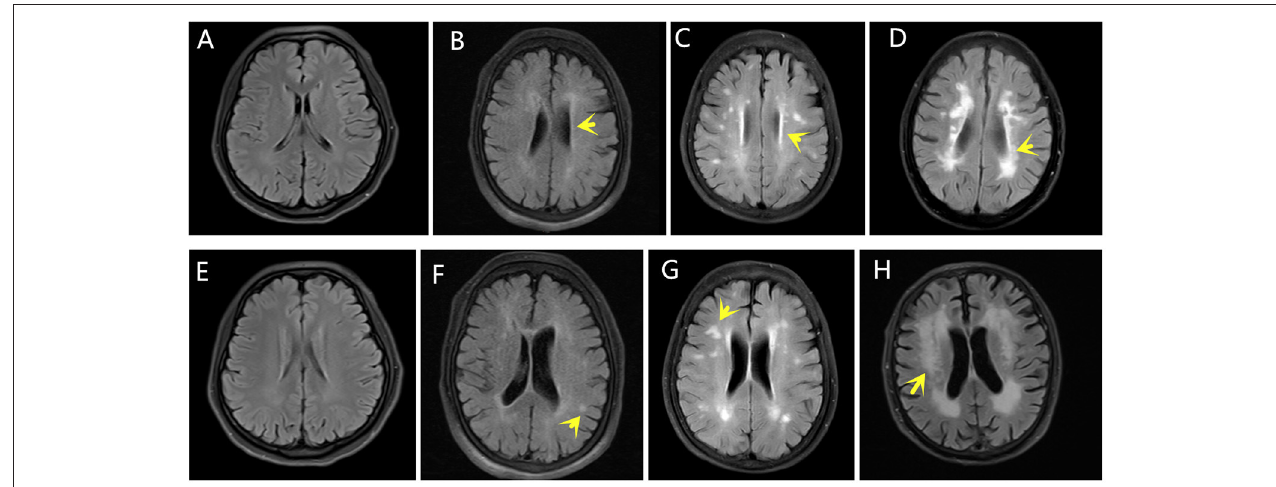
FIGURE 1 | Fazekas scores. The yellow arrows indicate WMLs on FLAIR MRI. The PV scores were categorized as follows: (A) 0, (B) 1, (C) 2, (D) 3. The DWM scores were categorized as follows: (E) 0, (F) 1, (G) 2, (H)